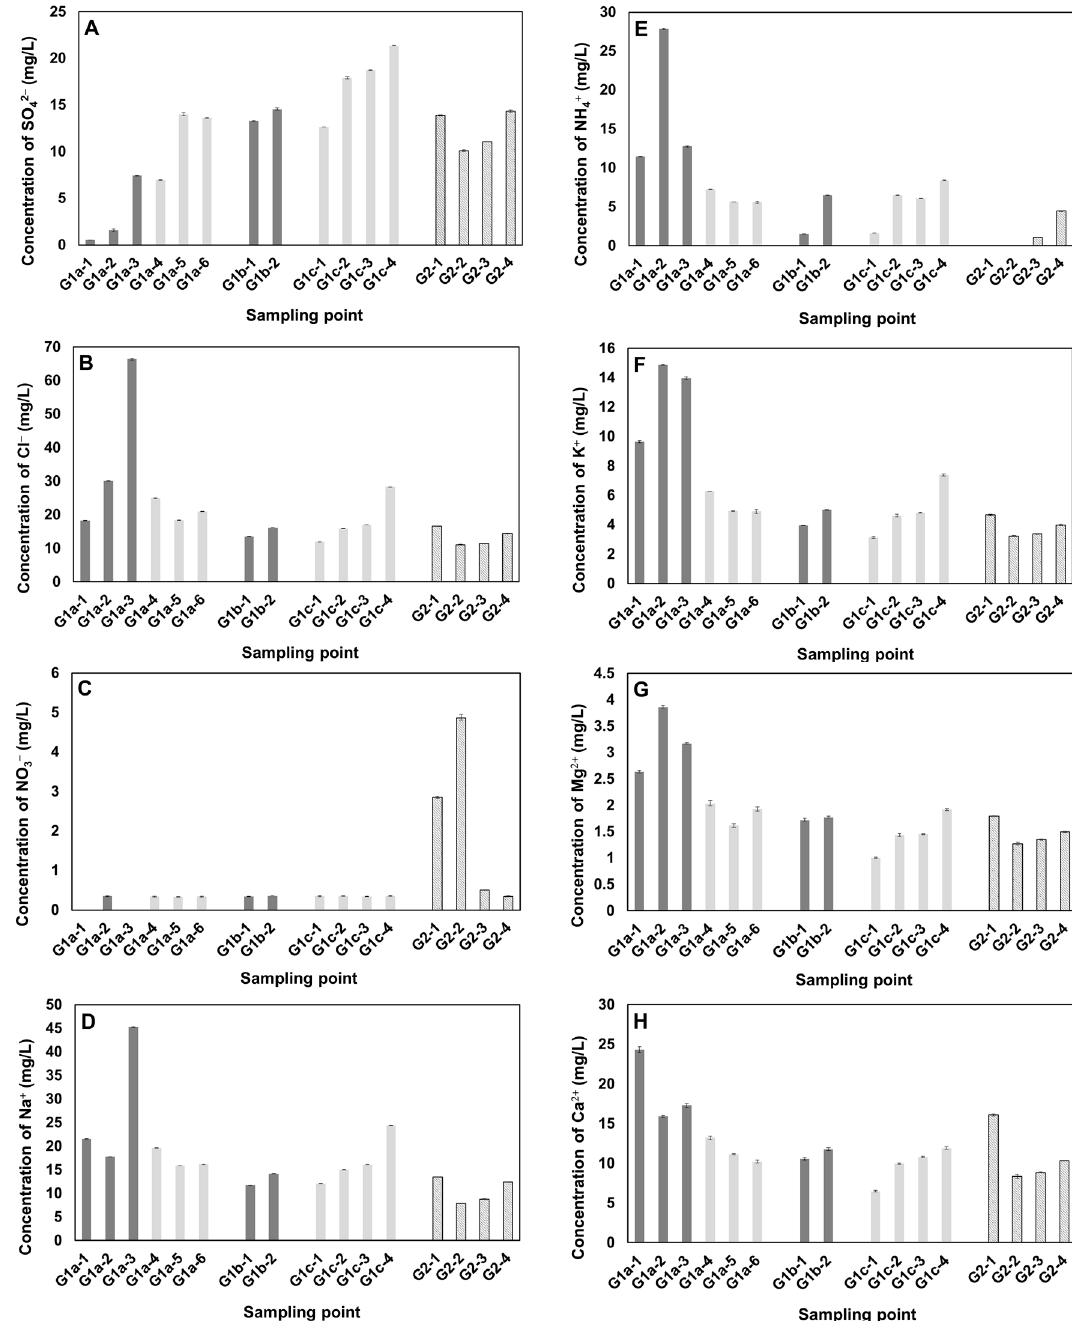
Figure 3. Changes in ionic concentrations: ( A ) SO 42 − ; ( B ) Cl − ; ( C ) NO 3 − ; ( D ) Na + ; ( E ) NH 4+ ; ( F ) K + ; ( G ) Mg 2+ ; and ( H ) Ca 2+ in the Galing River.